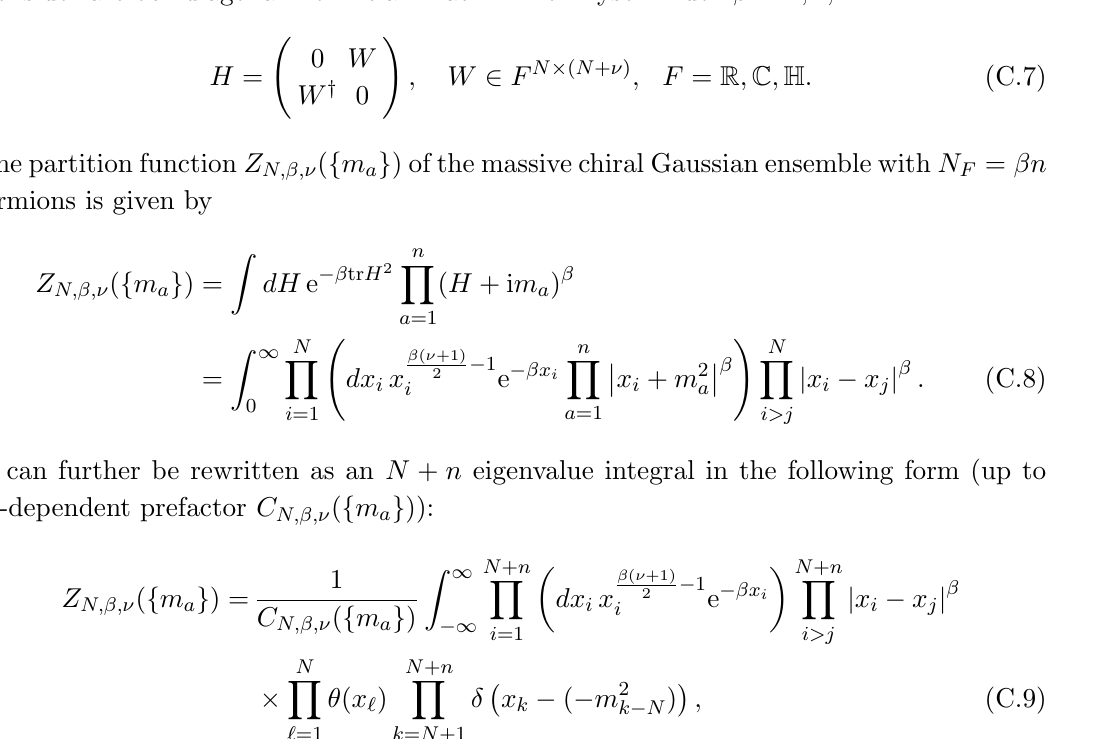
< 0: the Janossy density J a